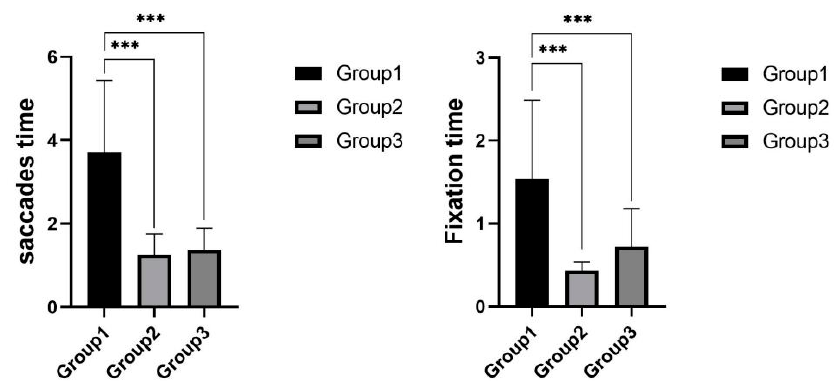
Figure 13. Saccades time and fixation time in speeding task. *** indicates significant difference ( p < 0.001).